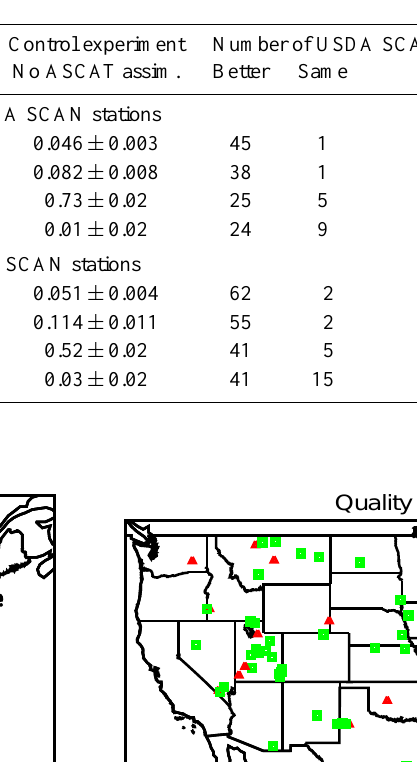
Table 1. Verification statistics for trial 1 of UM level 1 soil moisture analyses compared with in-situ USDA SCAN soil moisture observations. The Test experiment assimilates ASCAT surface soil wetness measurements while the Control experiment doesn’t use ASCAT measurements. Results are shown both with and without an objective quality control of the USDA SCAN stations. The verification shows that assimilation of ASCAT surface soil wetness improves the agreement between the UM soil moisture analyses and USDA SCAN in-situ soil moisture observations, this is the case regardless of whether the USDA SCAN stations are quality controlled.